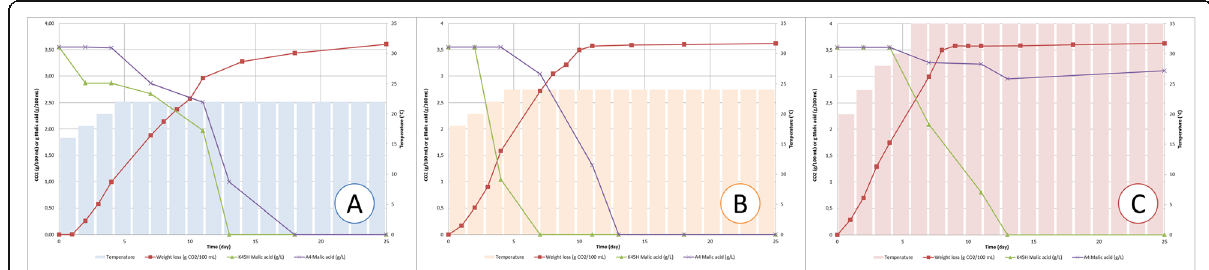
Fig. 1 Evolution of alcoholic and malolactic fermentation in function of different temperature profiles in grape must of cv. Chardonnay suitable for the production of sparkling wine (mean data, n = 6 for AF and 3 for MLFs). a T1 test: 16/22 °C in 3 days, b T2 test: 18/24 °C in 3 days, and c T3 test: 22/32 °C in 5 days. The highest temperature profile interfered by the accomplishment of MLF by the O. oeni A4 strain